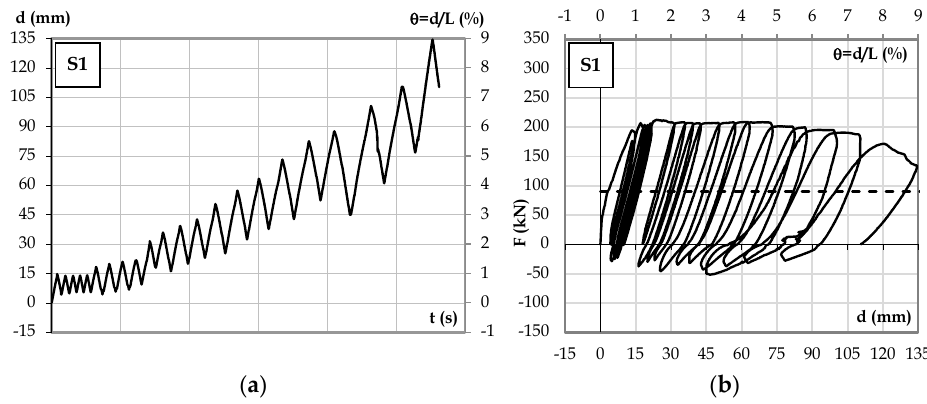
Figure 8. Specimen S1: ( a ) displacement history; ( b ) force-displacement hysteretic diagram. The displacement history and the force-displacement diagram of Specimen S2 are shown in Figure 9. A maximum load of 260.10 kN and 5.30% beam rotation were attained. In relation to Specimen S1, this beam showed a higher strength capacity and lower residual deformation.